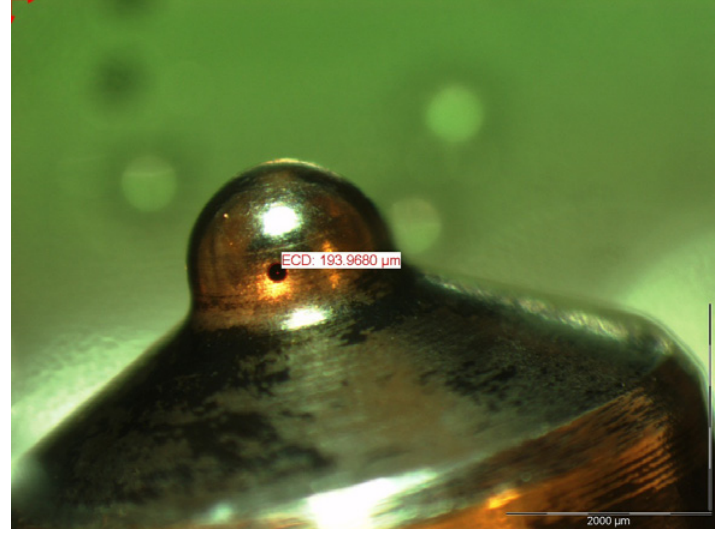
Figure 6. The injector orifice equivalent circle diameter (ECD).